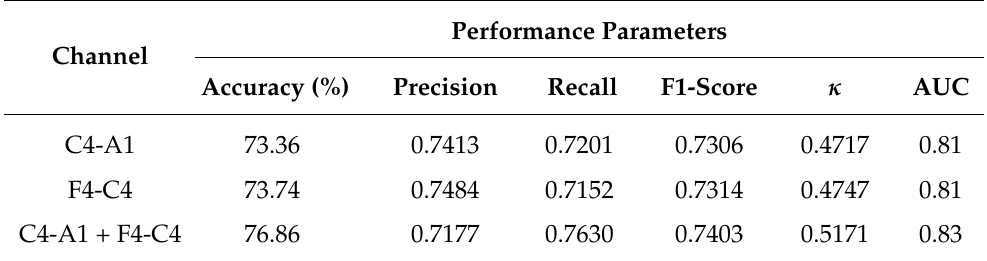
Table 16. CAP phase classification results obtained for healthy subjects without wavelet